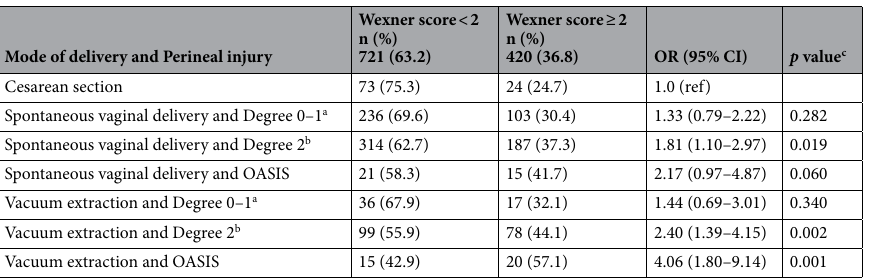
Table 4. Interaction between delivery mode and perineal injury on the risk of Wexner score ≥ 2. a No diagnosis, 1st degree or isolated vaginal tear. b 2nd degree including episiotomy. c P values according to interaction analysis including the terms ‘delivery mode’, ‘perineal injury’, and ‘delivery mode*perineal